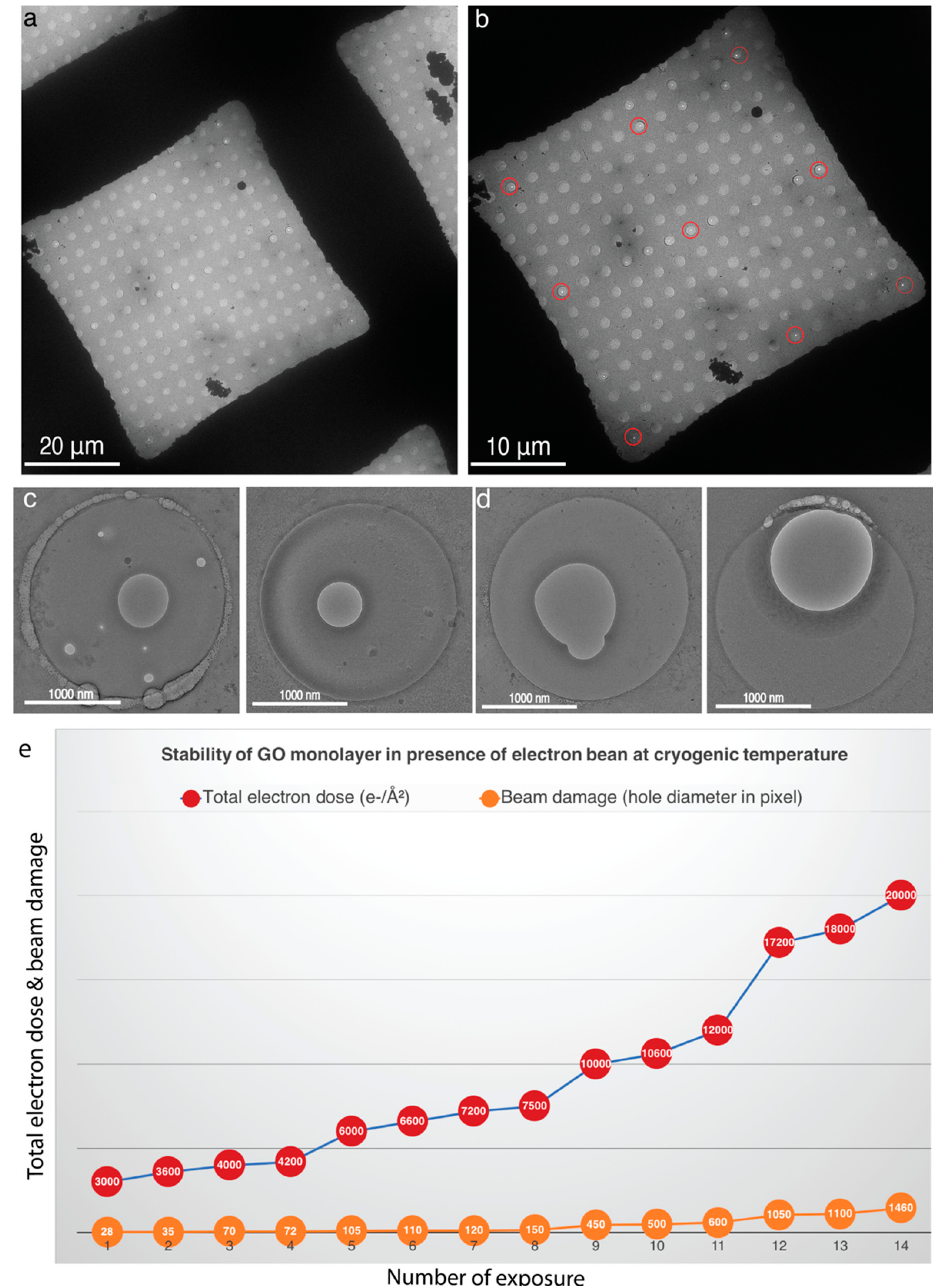
Figure 6. Stability of GO monolayer on electron beam exposure at cryogenic temperature: ( a ) Cryo-TEM image at 115 × magnification shows the formation of thin amorphous ice on the GO monolayer supported holey copper carbon grid. Overall amorphous ice distribution is uniform. ( b ) Evenly spread GO monolayer spanning an entire grid square observed at 380 × magnification. ( c , d ) 4300 × magnification of a GO monolayer covered hole after multiple exposures to electron beam for different exposure times from 30–200 s and a dose of 100 e − /Å 2 /sec ( c ) and a single prolonged exposure for 200 s and dose of 100 e − /Å 2 /sec ( d ) still showing intact GO around exposed areas. ( e ) Graph showing pixel wise damage of GO monolayer with varying electron dose. The red circles indicate the electron dose while the orange circles denote the damage in terms of pixels. It clearly shows that overall damage of GO monolayer is almost negligible even if the total electron dose is 3000–7500 e − /Å 2 . Orange curve shows that damages are more severe if GO monolayer is exposed for strong electron dose (10,000–20,000 e − /Å 2